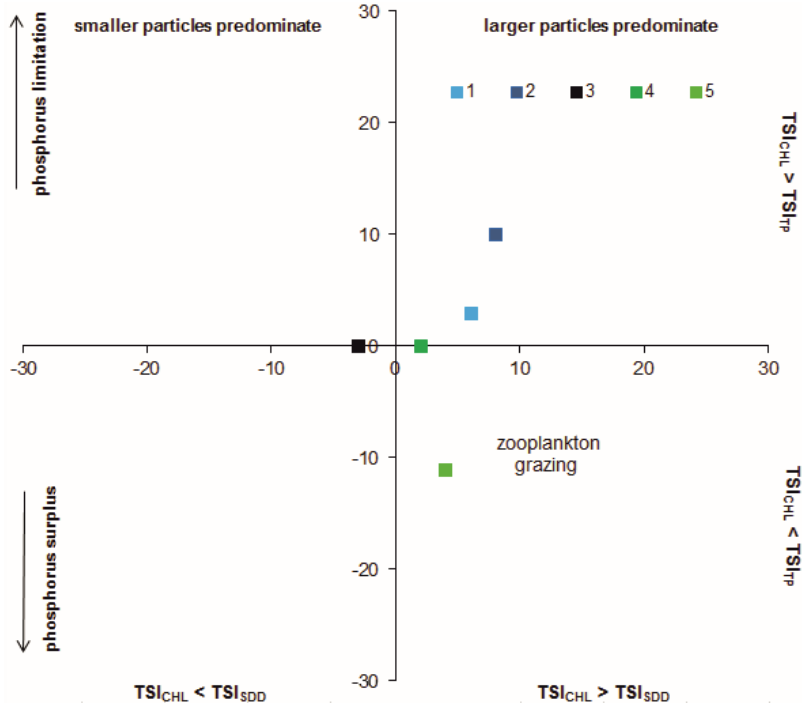
Figure 9. Trophic state index (TSI) deviation plot at sites 1 –4 in Lake Warnołty and site 5 in Lake